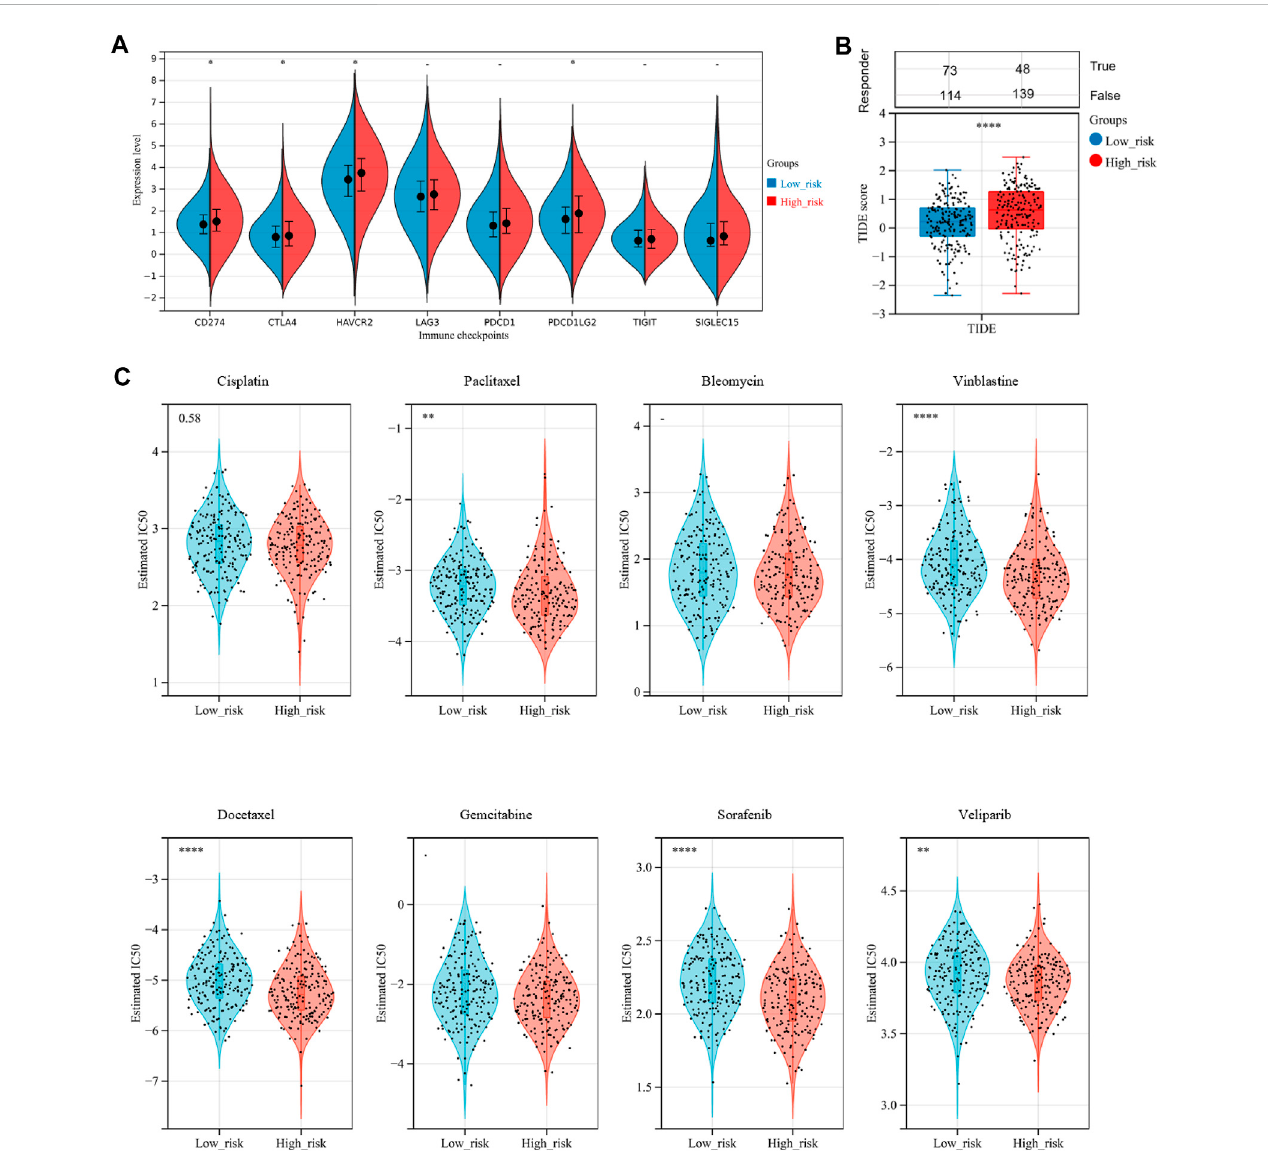
FIGURE 9 Assessment of sensitivity to immunotherapy and chemotherapy among OV patients. (A) The distribution of immune checkpoints gene expression between the low-risk and high-risk groups. (B) Immunotherapy response prediction for OV patients between the low-risk and high-risk groups, based on the Tumor Immune Dysfunction and Exclusion (TIDE) analysis. (C) The distribution of the estimated IC50 values for eight typical chemotherapies, including Cisplatin, Paclitaxel, Bleomycin, Vinblastine, Docetaxel, Gemcitabine, Sorafenib, and Veliparib in the Genomics of Drug Sensitivity in Cancer (GDSC) database for low-risk and high-risk groups. NS, not signi fi cant; * p -value < .05; ** p -value < .01; *** p -value < .001; **** p -value <